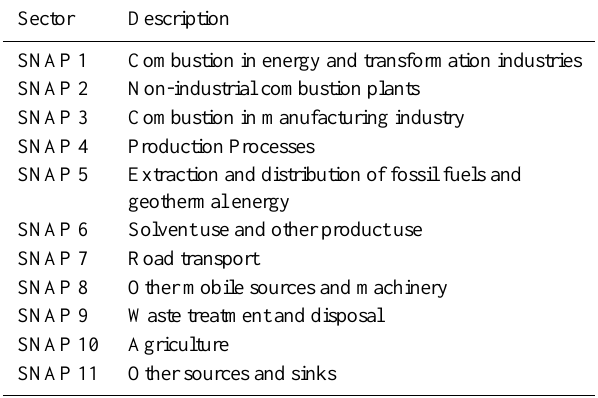
Table 1. SNAP: Selected Nomenclature for sources of Air